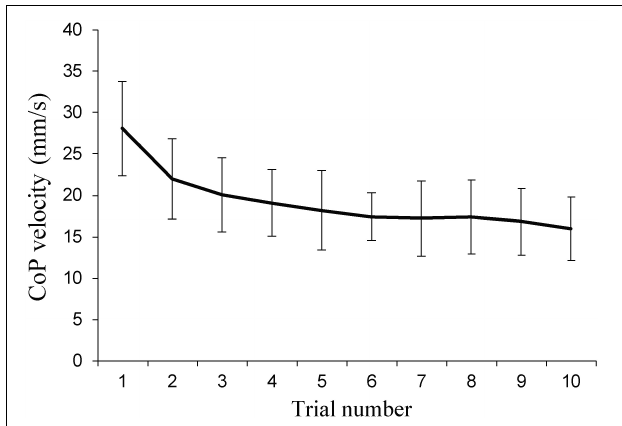
FIGURE 2 | Within-session behavior of center of pressure (CoP) velocity in the pilot experiment ( n = 12).